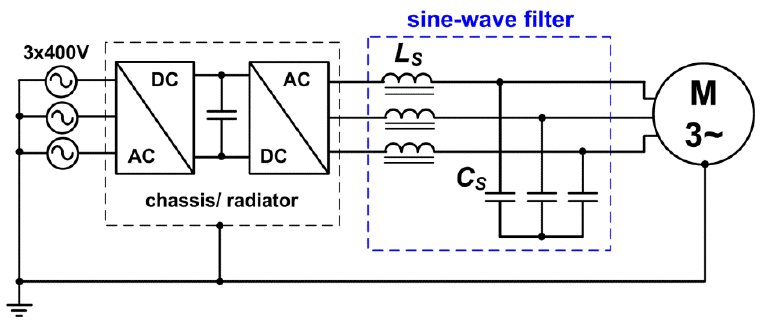
Figure 10. Electric drive with a sine-wave filter.